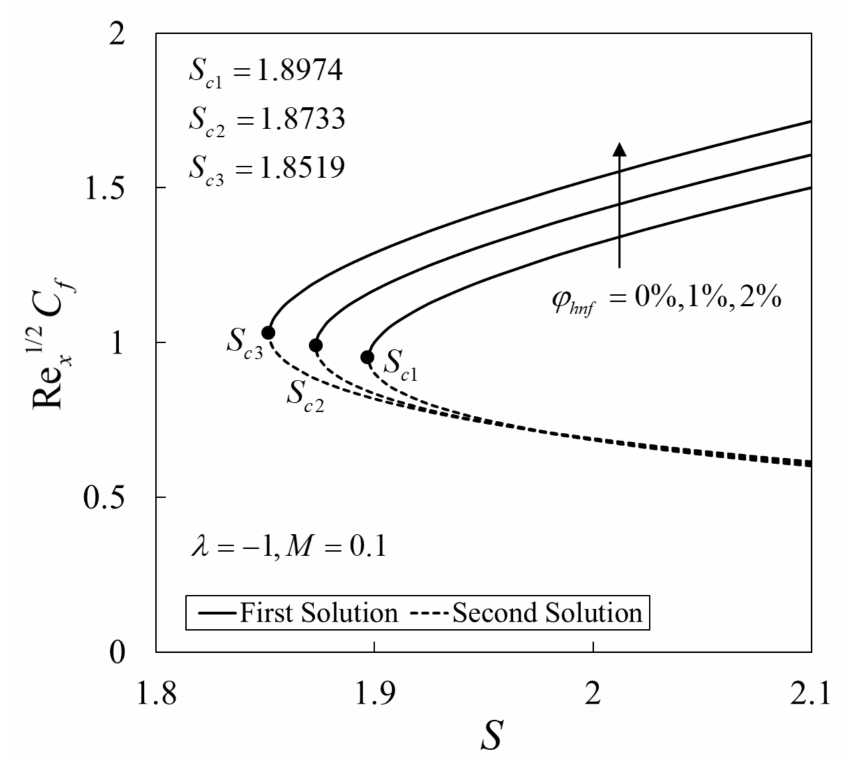
Figure 4. Variations of the skin friction coefficient Re 1/2 x C f against suction parameter S for different values of ϕ hnf .